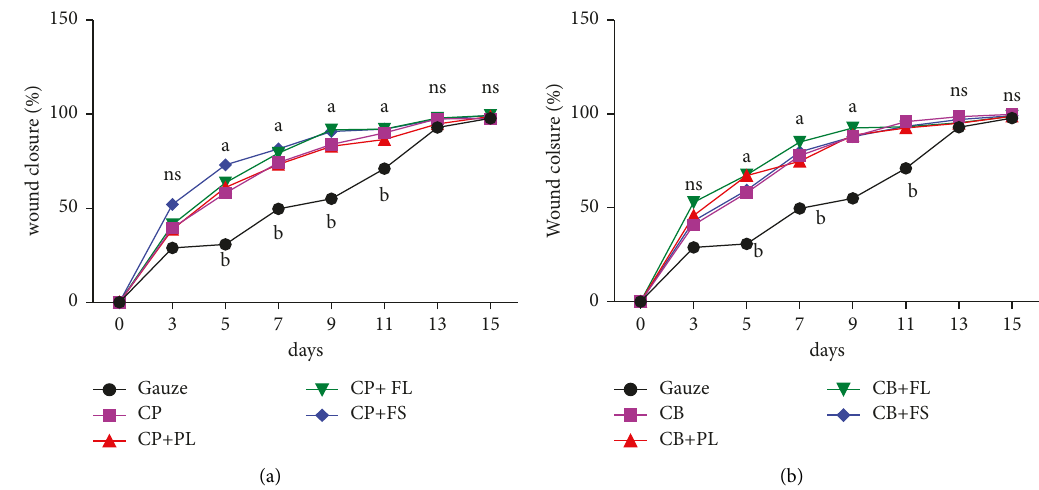
(b) 8) results are presented as mean SD. PL: P. lentiscus (cid:30) ±